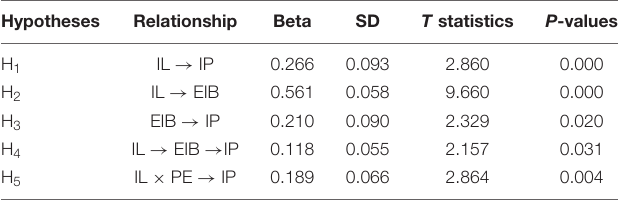
TABLE 4 | Heterotrait-Monotrait ratio (HTMT). TABLE 5 | Structural model assessment.